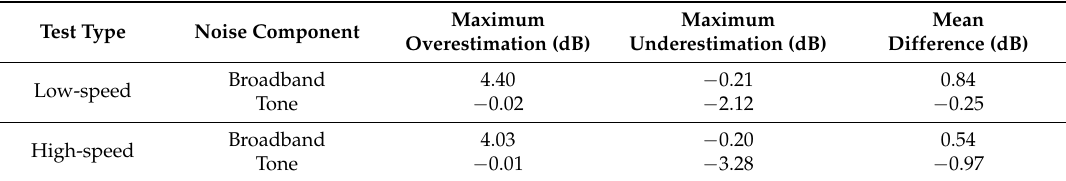
Table 4. Differences in overall sound pressure level (OASPL) of tone and broadband noise of F31/A31 model computed using the spectral results from original and modified